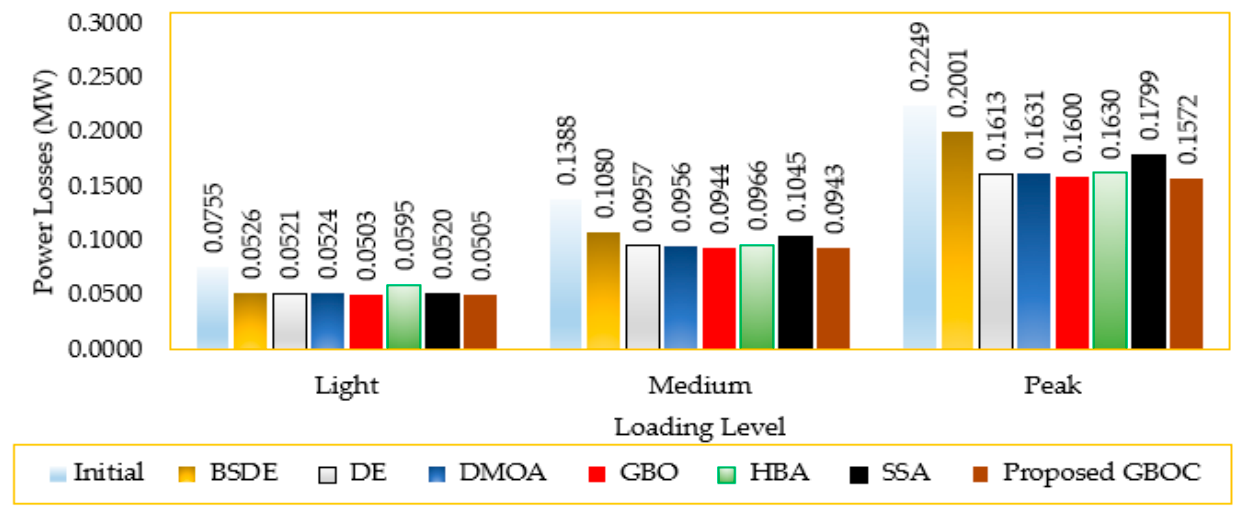
Figure 17. Power losses (MW) in each loading level based on the obtained D-SVC devices in Table 6 compared to the initial case.